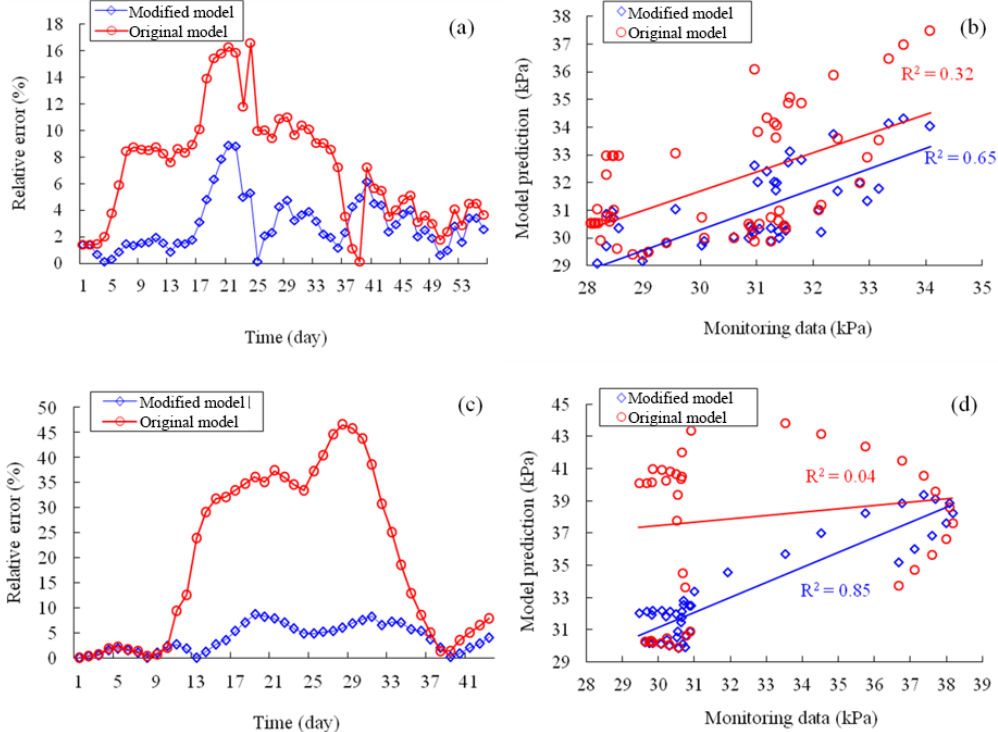
Figure 12. Evaluation of original and modified tank model. (a) Correlation between measurements and original/modified tank model during a 54-day rainfall period ( n = 54). Root mean square errors (RMSE) for the original and modified models are 1.9 and 0.97, respectively. (b) Correlation between measurements and original/modified tank model in snowmelt period ( n = 47). The RMSE approaches 5.4 and 1.3 for the original model and the modified model. (c) Relative error of original and modified tank model in summer ( n = 54). (d) Relative error of original and modified tank model during spring ( n = 47).